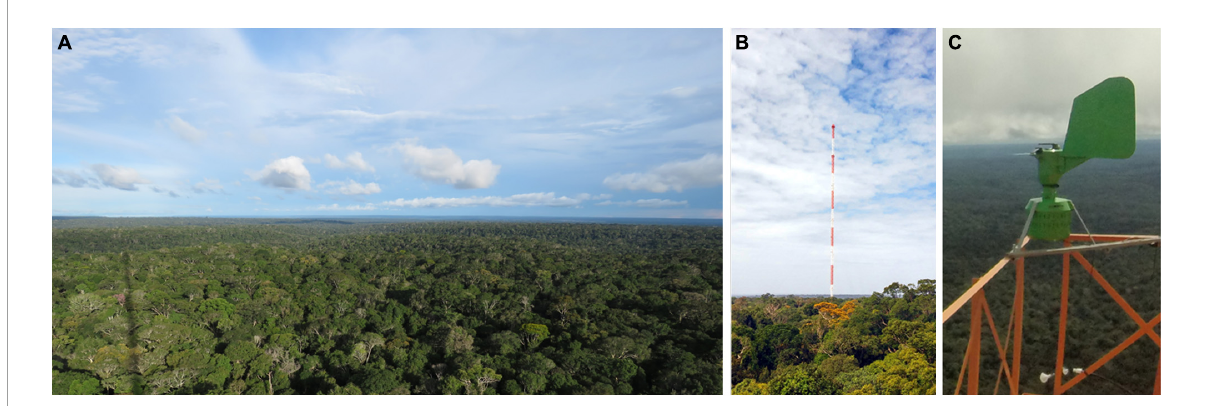
FIGURE1 View of the Amazon forest from the ATTO tower at 100 m height (A) . View of the ATTO tower (B) . Spore sampler installed at the edge of the tower at 300 m height (C) . Photos by SMO (A,C) and Jorge Saturno MPI-C (B)